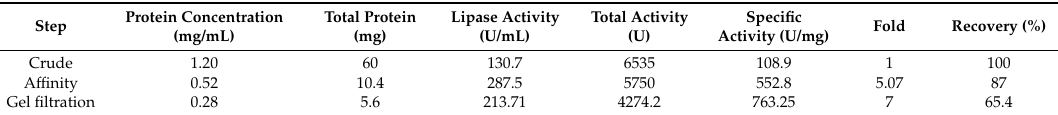
Figure 6. Polyacrylamide gel electrophoresis (PAGE) profile of the recombinant truncated AMS3 lipase. Lane (1) Unstained protein molecular weight marker (Fermentas, Germany); Lane (2) Crude truncated AMS3 lipase; Lane (3) Truncated AMS3 lipase purified through affinity chromatography; Lane (4) Unstained protein molecular weight marker; Lane (5) Purified truncated AMS3 lipase; Lane (6) Native-PAGE. Table 2. Truncated AMS3 lipase purification. The recombinant lipase was purified through one step affinity chromatography.